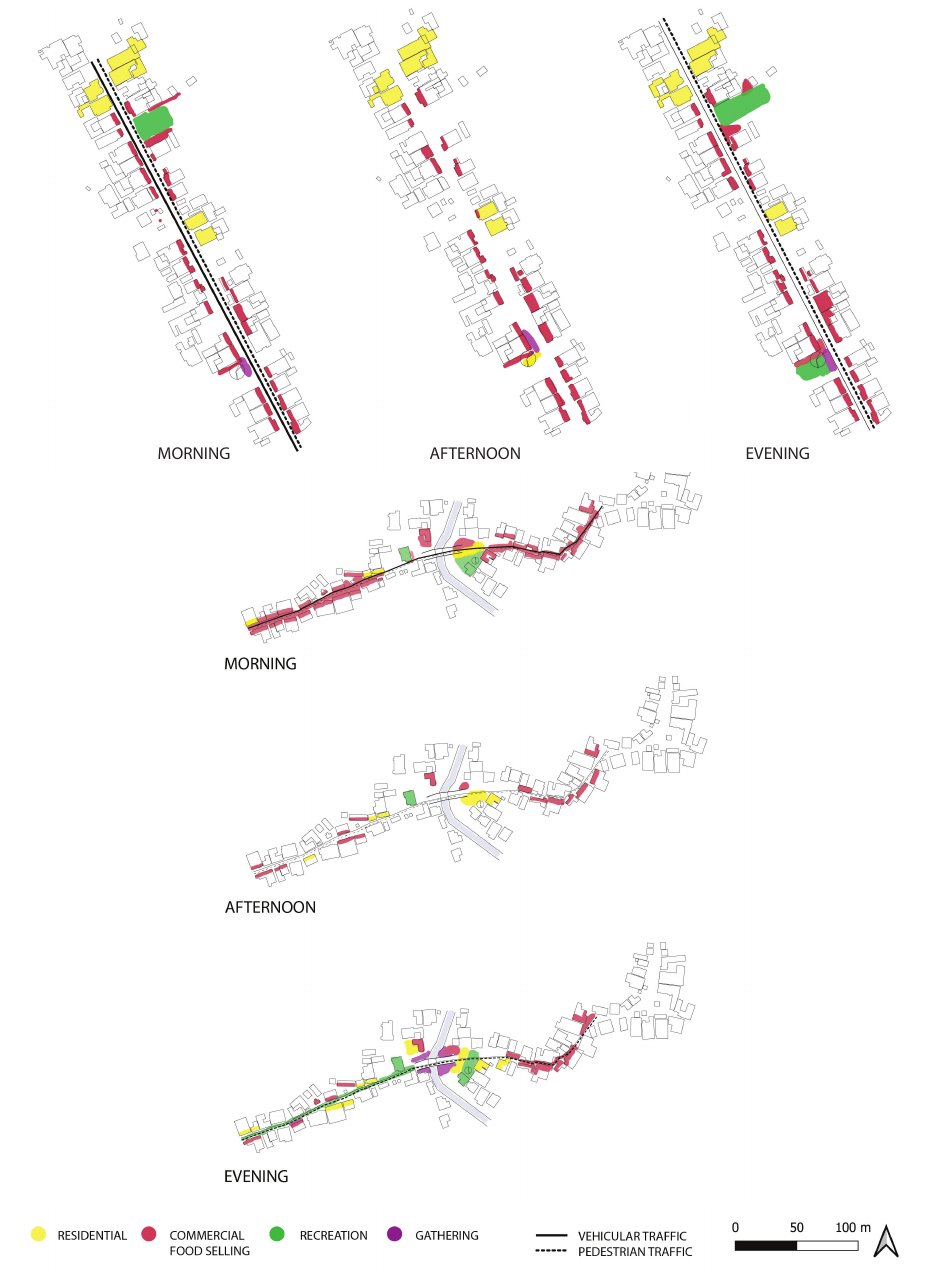
Figure 8. Daily functions, activities, and changes at a typical street in Mwananyamala (horizontal lineup) and Tandale (ver‐ tical lineup). Source: Courtesy of Lerys